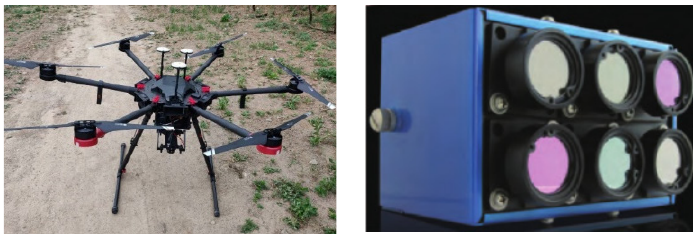
Figure 1. M600 UAV and Micro-MCA multispectral camera.